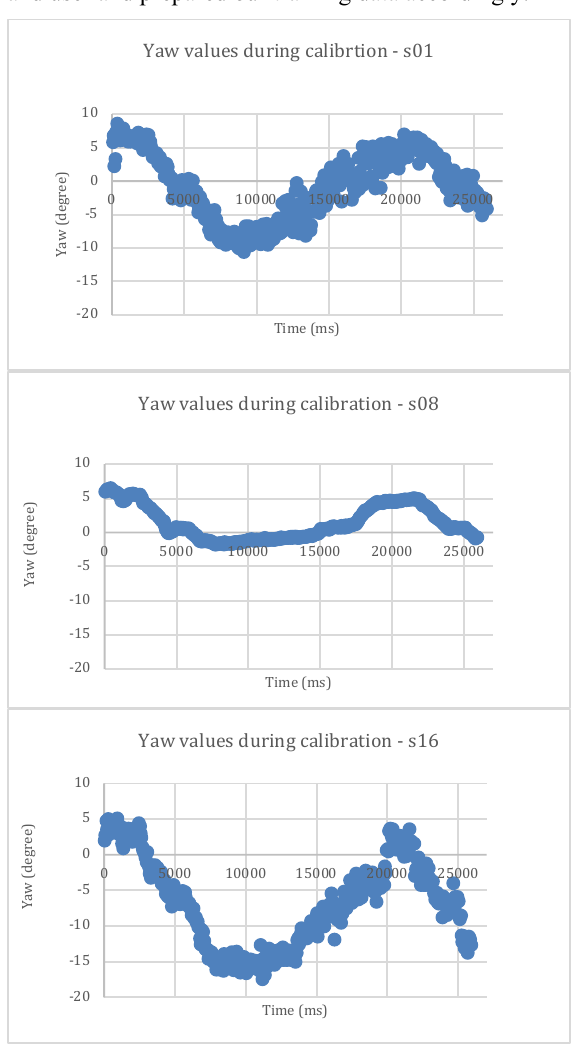
Figure 5. Profile of yaw predictions by OpenFace while users performing our calibration